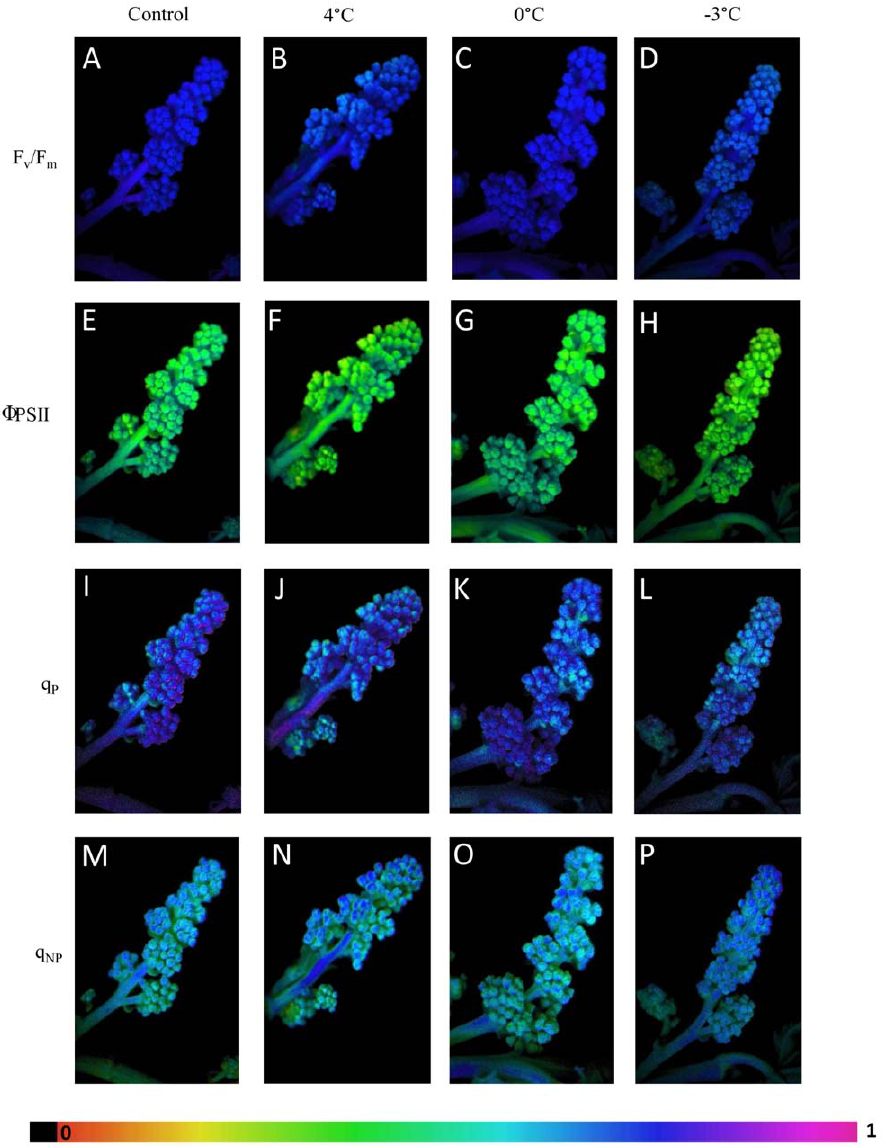
Figure 4. Images of chlorophyll fluorescence parameters at 2 h after the end of the night in control and 4 6 C, 0 6 C or 2 3 6 C-treated mobilize soluble sugars but not starch. A cold night is followed by a simultaneous decrease of soluble sugars (glucose, fructose and sucrose) and starch accumulation as previously shown [28]. that respiration is drastically impaired by a night at 0 u C [66]. up by other plant organs, especially after the end of the cold night. undergo modifications, showing an accumulation of glucose and sucrose at 24 h without variation in starch content.